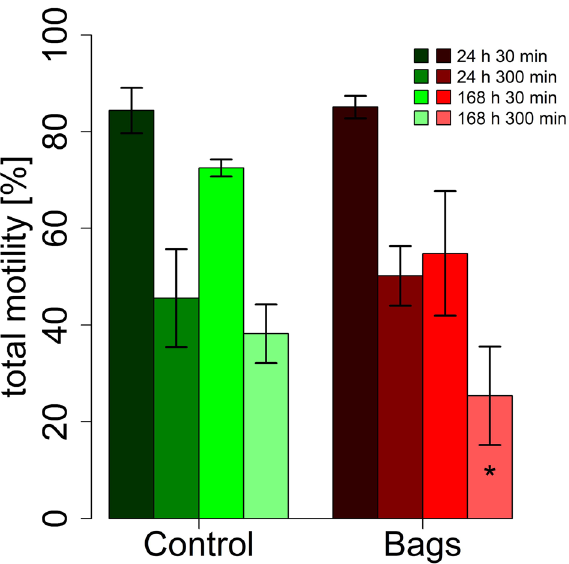
Figure 4. Thermo-resistance test of boar spermatozoa in sixteen pooled ejaculates (4 × 4 ejaculates) from 16 mature Pietrain boars after 24 and 168 h of semen storage. Significance of differences between MEDI NOVA bags and control * P <